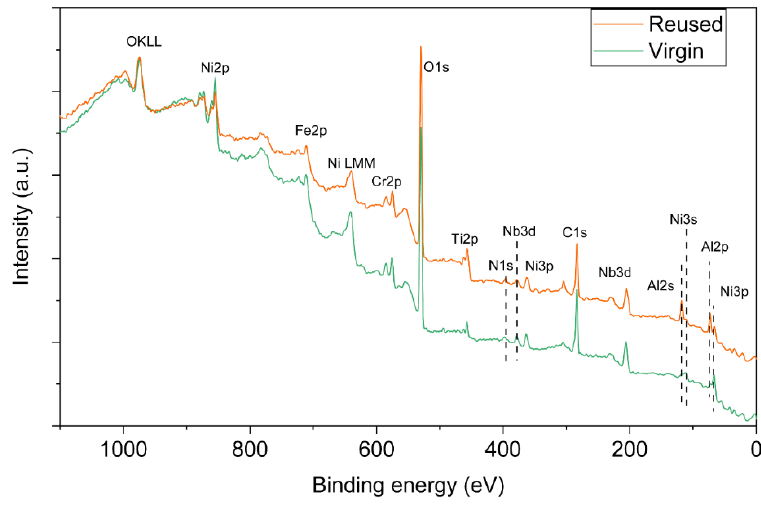
Figure 4. XPS survey spectra of virgin and PBF-EB reused Alloy 718 powder.